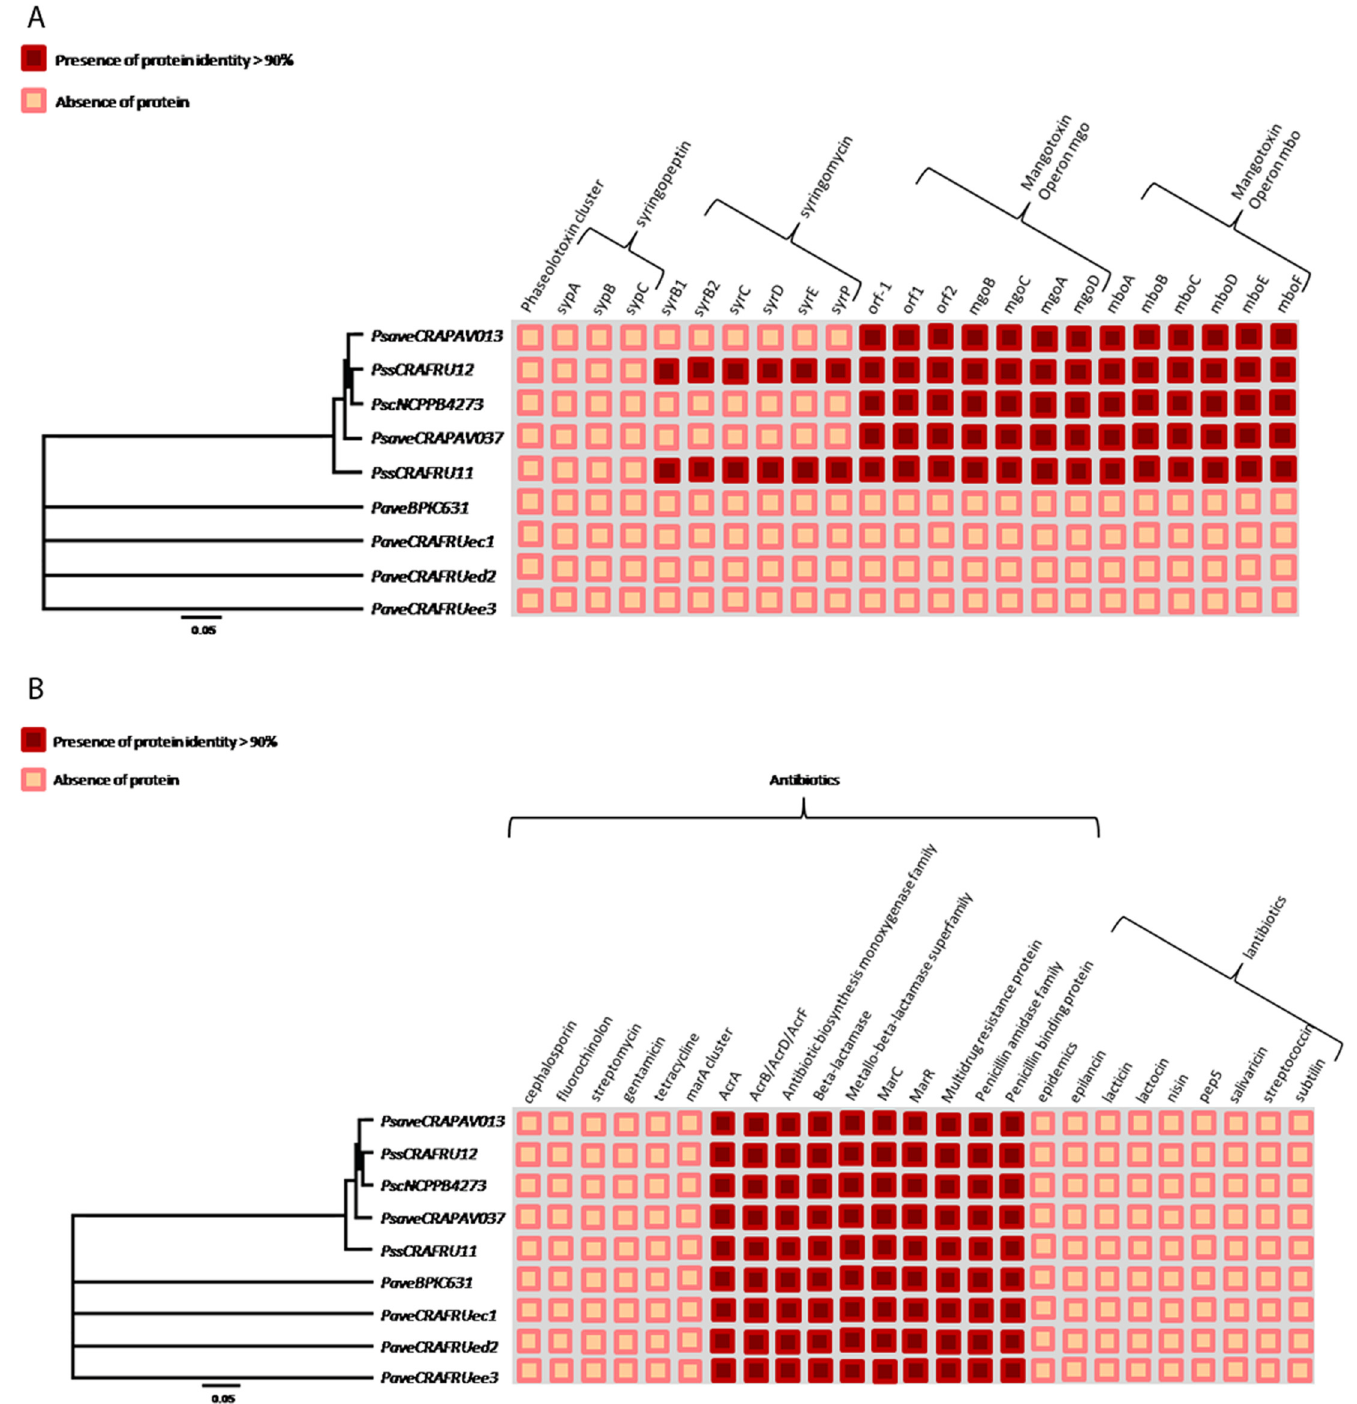
Fig 7. Presence/absence of putative homolog proteins in nine pseudomonad strains infecting Corylus avellana trees. The indication concerns the production of phytotoxins and antimetabolites (A), and antibiotic and lantibiotics (B). Strain legend is shown in Table 1.